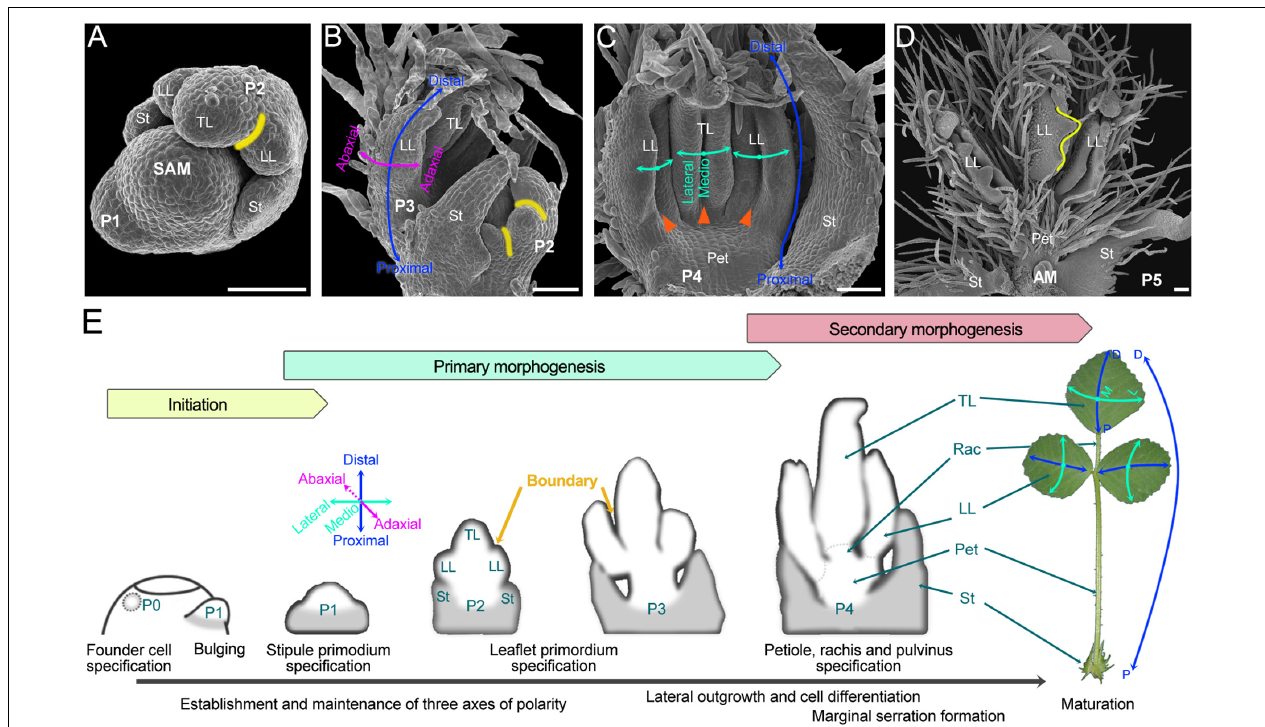
FIGURE 2 | The ontogeny of compound leaf development in M. truncatula . (A–D) SEM images of the shoot apical meristem (SAM) and/or developing leaf primordia. (A) The organization of the shoot apex with two leaf primordia developed at the SAM periphery. Primordia are named according to the plastochron (P) age: the latest emerging primordium is termed P1, the next oldest primordium P2, etc. The yellow curve marks the boundary between the terminal leaflet (TL) and the lateral leaflet (LL) primordia. St, stipule. (B) The organization of the shoot apex shows the SAM protected by P2 and P3 leaf primordia. Curved arrows mark the adaxial–abaxial (pink) and proximal–distal (blue) axes of leaf asymmetry. (C) Adaxial side view of the P4 leaf primordium. Cyan curved arrows mark the mediolateral axis. During stages P3 to P4, due to the abaxial surface outgrows the adaxial surface, the leaflet primordia became folded (orange triangle). (D) Adaxial side view of the P5 leaf primordium with the serrations (yellow curve) being formed. Pet, petiole. (Bars, 50 µ m). (E) Diagrams of compound leaf primordia at successive stages of ontogeny. The leaf development of M. truncatula can be divided into three successive phases. The first is the initiation of leaf primordium from the peripheral zone of SAM. The following is primary morphogenesis, during which three axes of leaf polarity are established, and three separated leaflet primordia, as well as primordial petiole and rachis, are formed. The last is secondary morphogenesis, during which the vasculature, leaf margins, and other specialized epidermal cells such as trichomes and stoma accomplish their differentiation to make a mature leaf. A mature trifoliate leaf exhibits both global and local polarity along the proximal-distal axis (rightmost): the global proximal-distal polarity is manifest in the distribution of distinct specialized organs along the proximal-distal axis (blue and long double-headed arrow), while each leaflet exhibits independent local proximal-distal polarity (blue and short double-headed arrows). Rac, rachis.